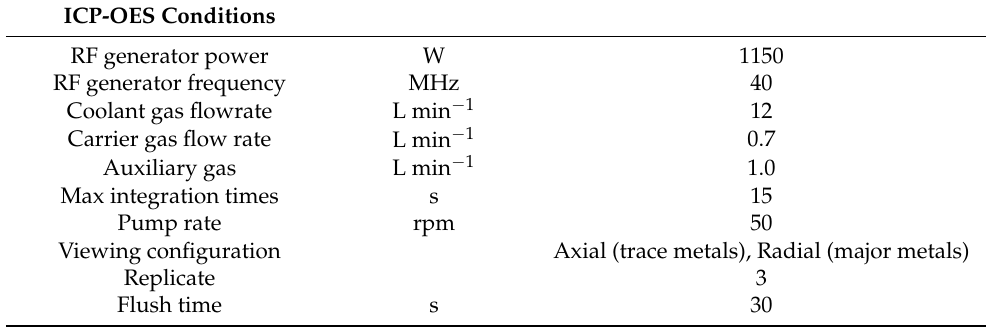
Table 1. Operating conditions of